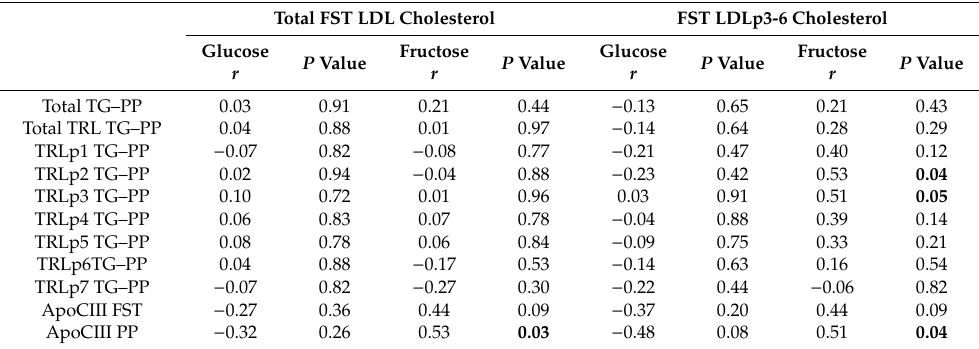
Table 3. The relationship of percent change of postprandial total, TRL subfraction TG, and fasting